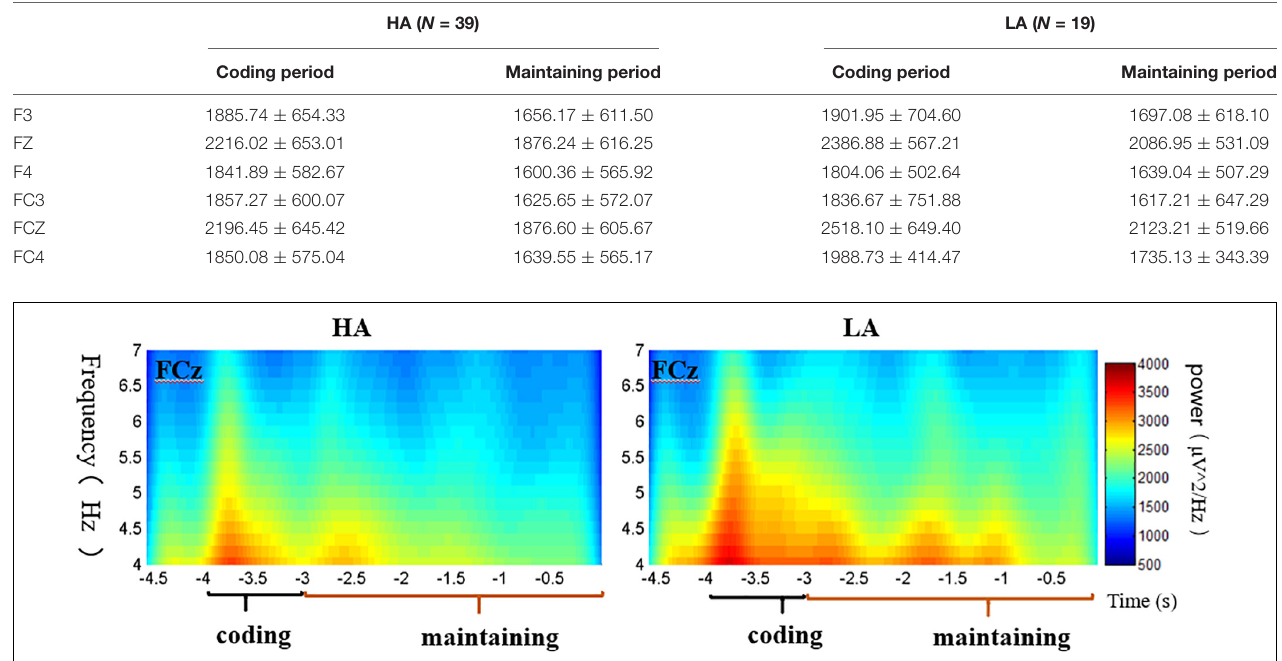
TABLE 5 | θ -ERS of each group in DSM task (Power, µ V 2 /Hz).